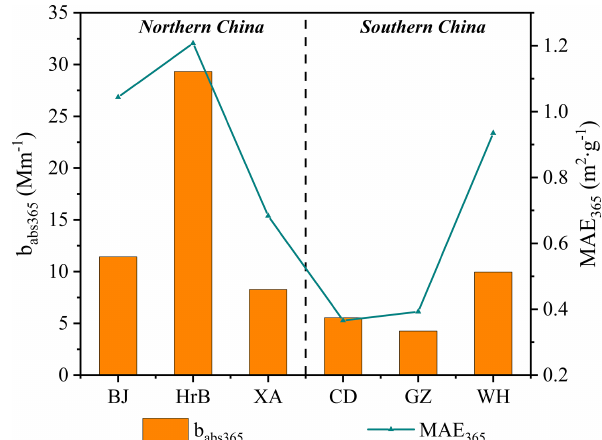
Figure 2. Spatial variations of BrC light absorption properties from six Chinese cities. The bars represent the light absorption coefficient at 365nm ( b abs365 , left axis), and the lines represent the mass ab- sorption efficiency at 365nm (MAE 365 , right